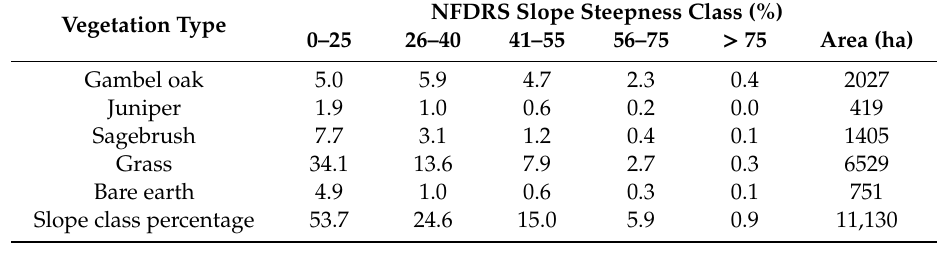
Table 3. Matrix of vegetation class distribution within the National Fire Danger Rating System (NFDRS) slope steepness classes at Army Garrison Camp Williams.